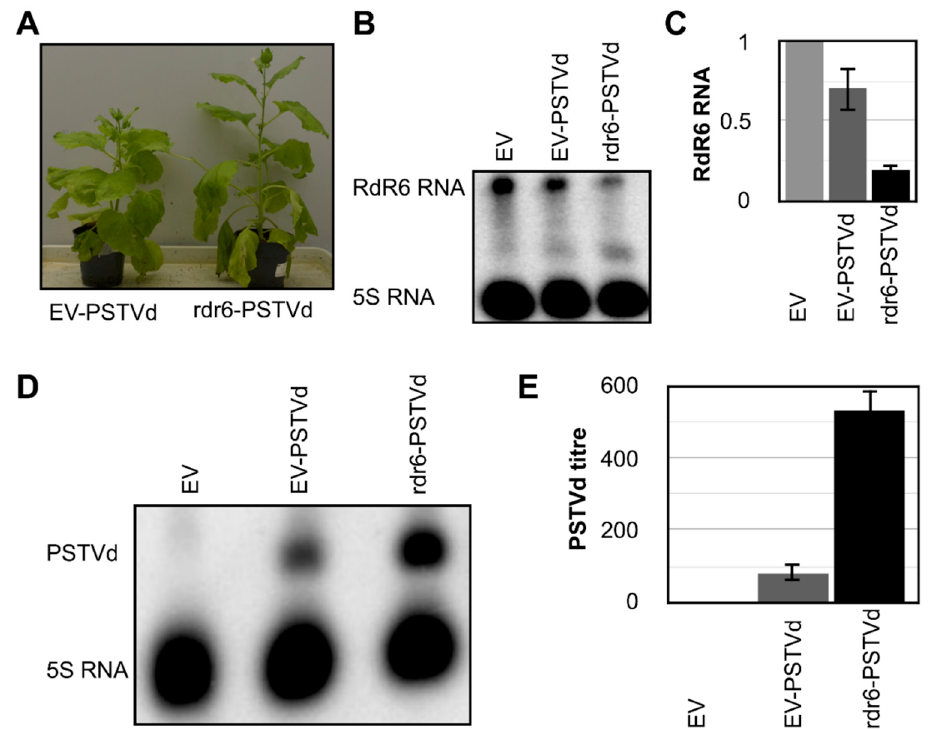
Figure 2. RdR6 compromised N. benthamiana plants exhibited higher amounts of PSTVd. The RdR6 knocked-down N. benthamiana plants were subjected to a PSTVd-RG1 infection assay in order to verify the role of the RdR6 mRNA in viroid accumulation. ( A ) At 21 days post-inoculation (dpi), the plants did not exhibit any viroid-associated disease symptoms. Total RNA extracted from N. benthamiana plants at 21 dpi was used to monitor the expression of RdR6 by ( B ) RNA gel blot and ( C ) RT-qPCR assay using RdR6 specific radiolabeled probes and primers, respectively. The same RNA sample was also used to evaluate the accumulation of PSTVd RNA by ( D ) RNA gel blot and ( E ) RT-qPCR assays using PSTVd specific radiolabeled probes and primers, respectively. In the ( E ) PSTVd titer represents the quantity of PSTVd RNA obtained by RT-qPCR. The expression change is presented on a log2 scale. The error bars indicate the standard deviation (SD). EV-PSTVd, plants agroinfiltrated with pTRV2-EV vector and infected with PSTVd-RG1; rdr6-PSTVd, plants agroinfiltrated with pTRV2-RdR6 vector and infected with PSTVd-RG1. Each experiment was performed at least three times with true biological replicates.